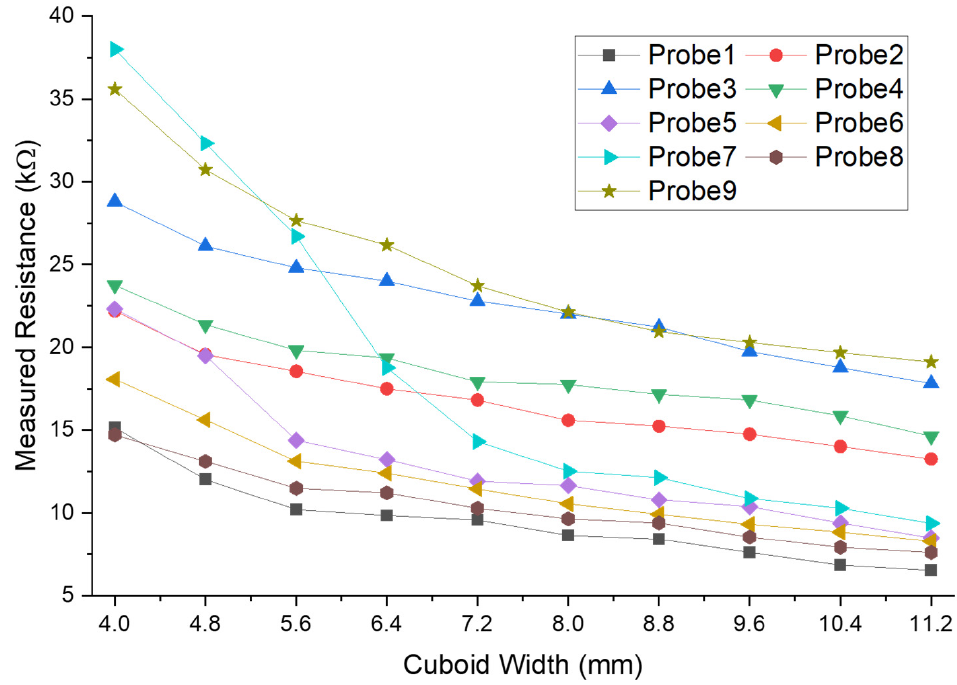
Figure 9. FSRs resistance versus cuboids width for 9 different probes.